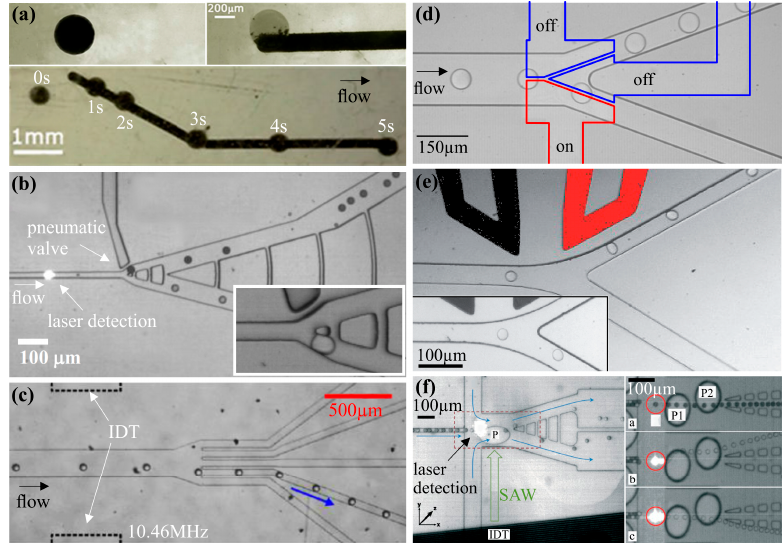
Figure 4. Active sorting of droplets. ( a ) Magnetic particles in droplets force the droplet towards the magnetic rail when a magnetic field is applied over the entire chip. With kind permission from Springer Science+Business Media: Microfluidics and Nanofluidics , Selective handling of droplets in a microfluidic device using magnetic rails . 2015, 19, 1 , 141–153, Teste et al. [64]. ( b ) Applying a pressure to the pneumatic valve changes the path of least resistance from the upper to the lower channel.